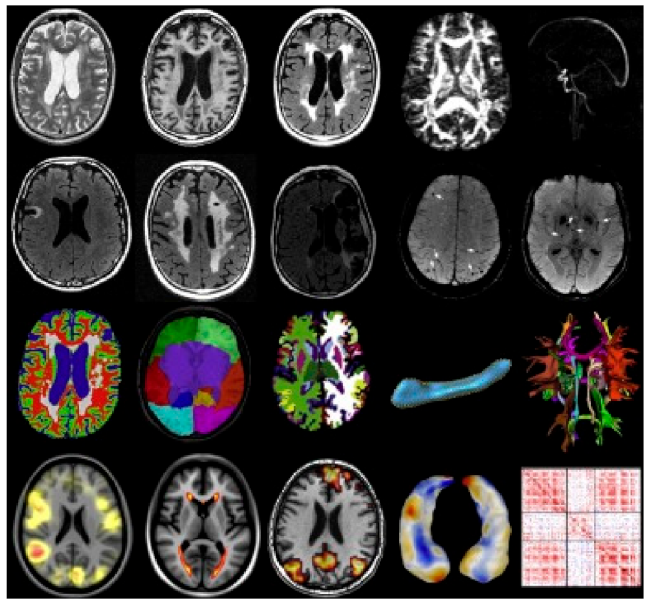
Figure 1. Examples of magnetic resonance imaging and quantitative imaging data of biomarkers in the brain. The biomarkers for quantitative imaging of the brain with dementia can be classified into four types: brain anatomy, brain function, and connectivity and vascular pathologies [65]. Reproduced with permission from Niessen, Medical Image Analysis; published by Elsevier,